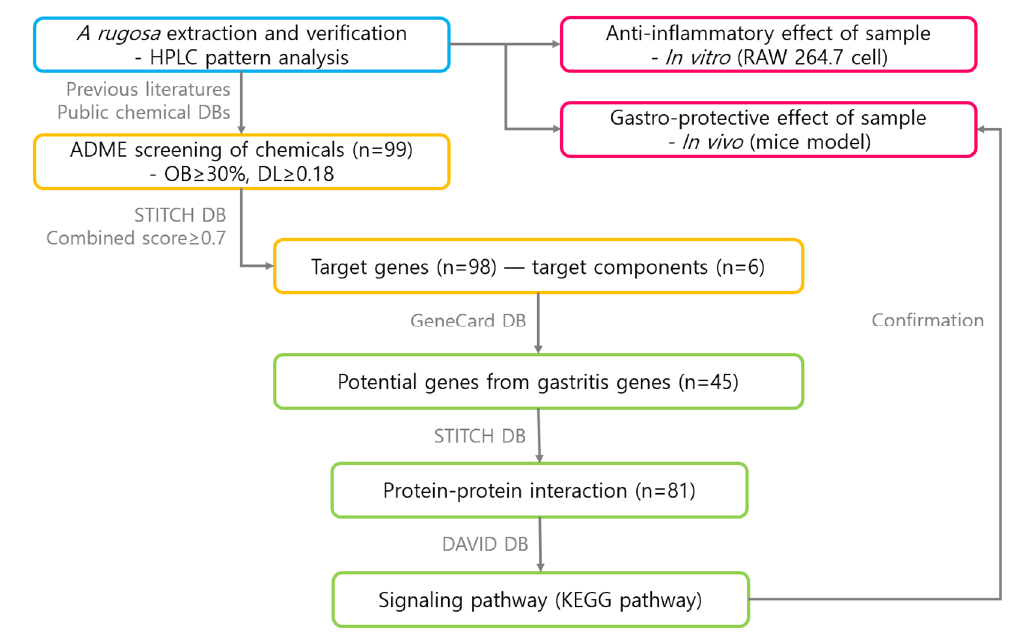
Figure 1. Workflow illustrating the network pharmacological analysis of A. rugosa.